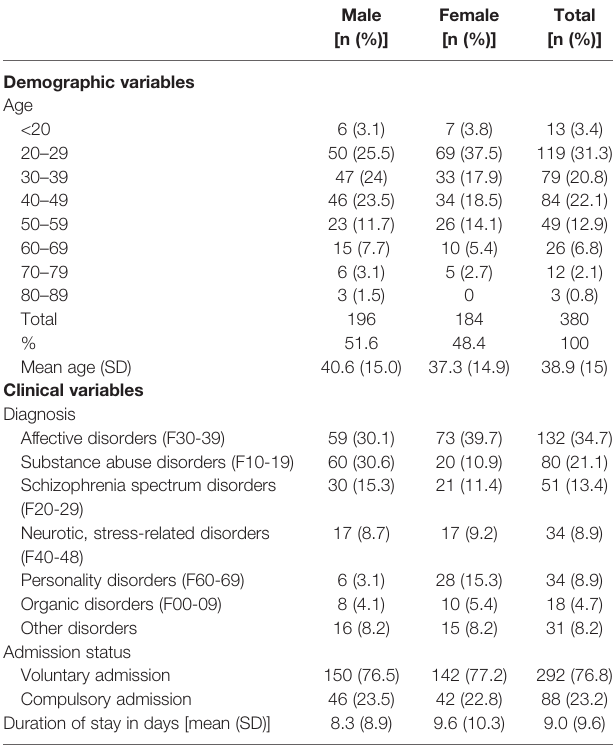
TABLE 2 | Characteristics of patients admitted to an acute psychiatric department from 2011 to 2012.